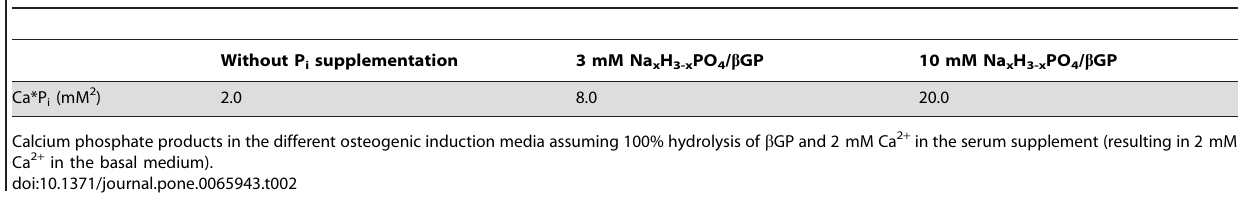
(TIF) Figure S2 Von Kossa and Alizarin Red S staining. Represen- tative data from day 28 of the osteogenic differentiation for the different phosphate sources is shown (Alizarin Red S: left panel, von Kossa: right panel) (TIF) Protocol S1. (DOCX)